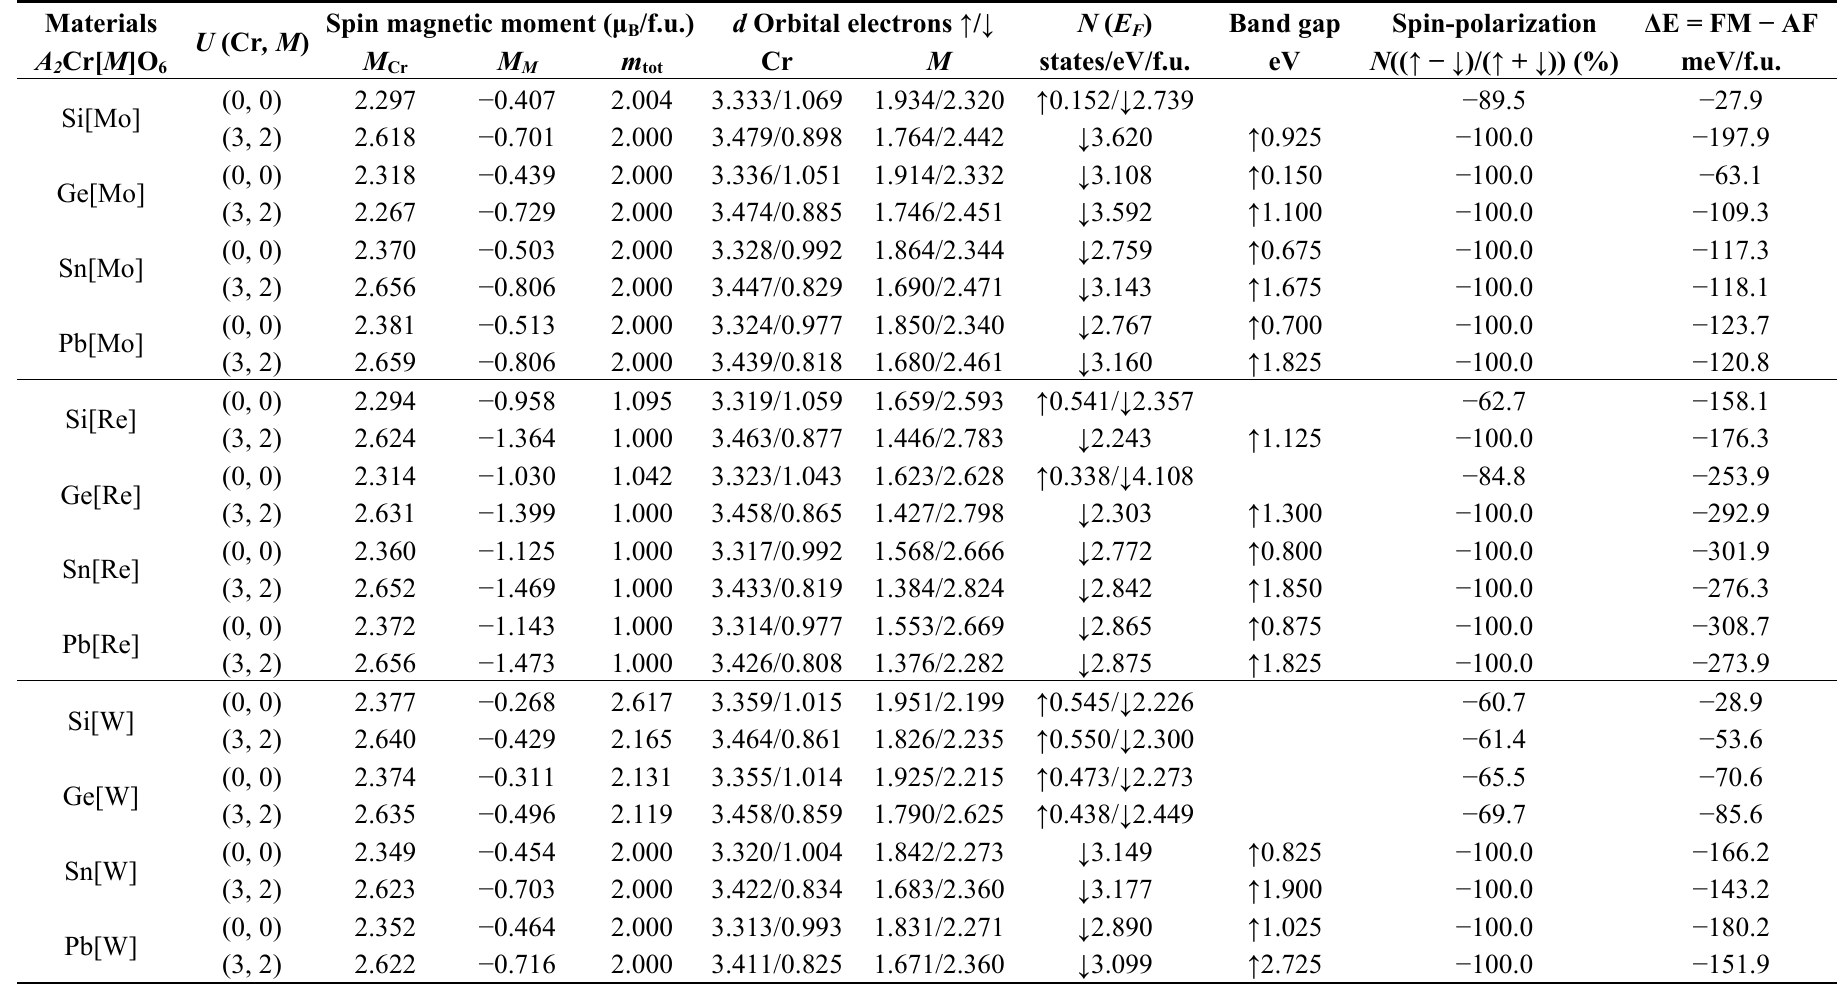
Table 1. Calculated physical properties of the A generalized gradient approximation (GGA) + U (Coulomb